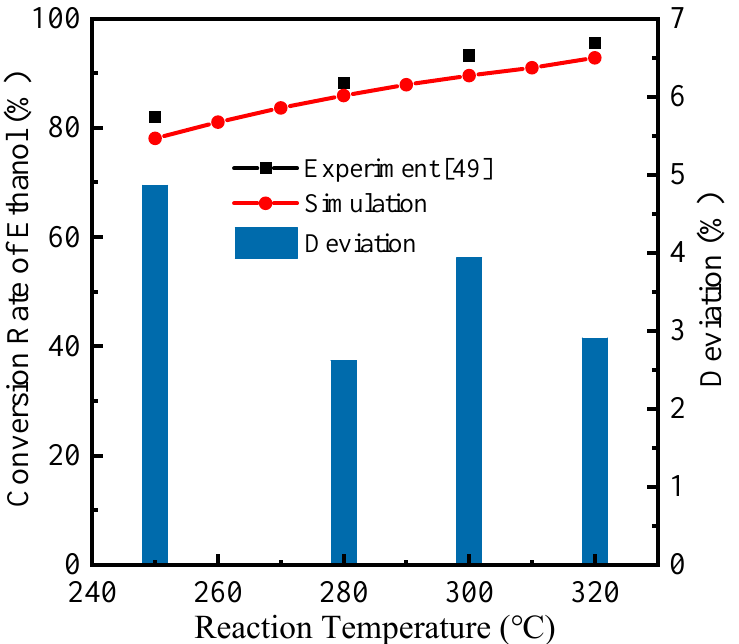
Figure 2. Comparison between theoretical and experimental ethanol conversion rate of ESR for model